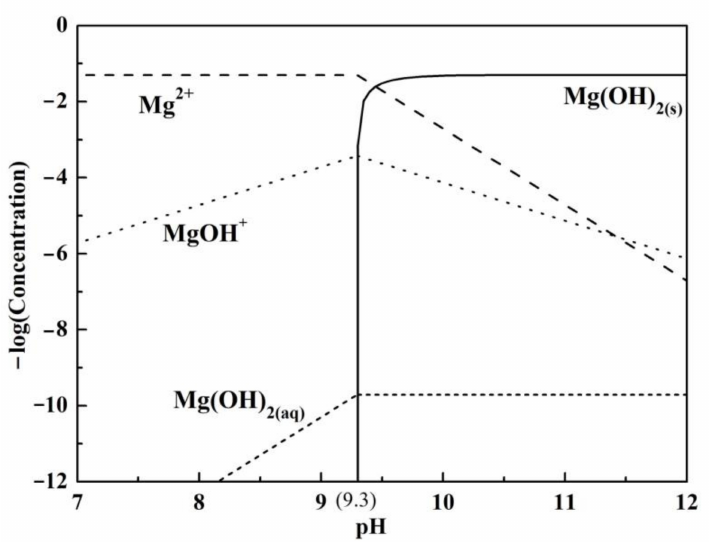
Figure 3. Solution species in 0.05 M MgCl 2